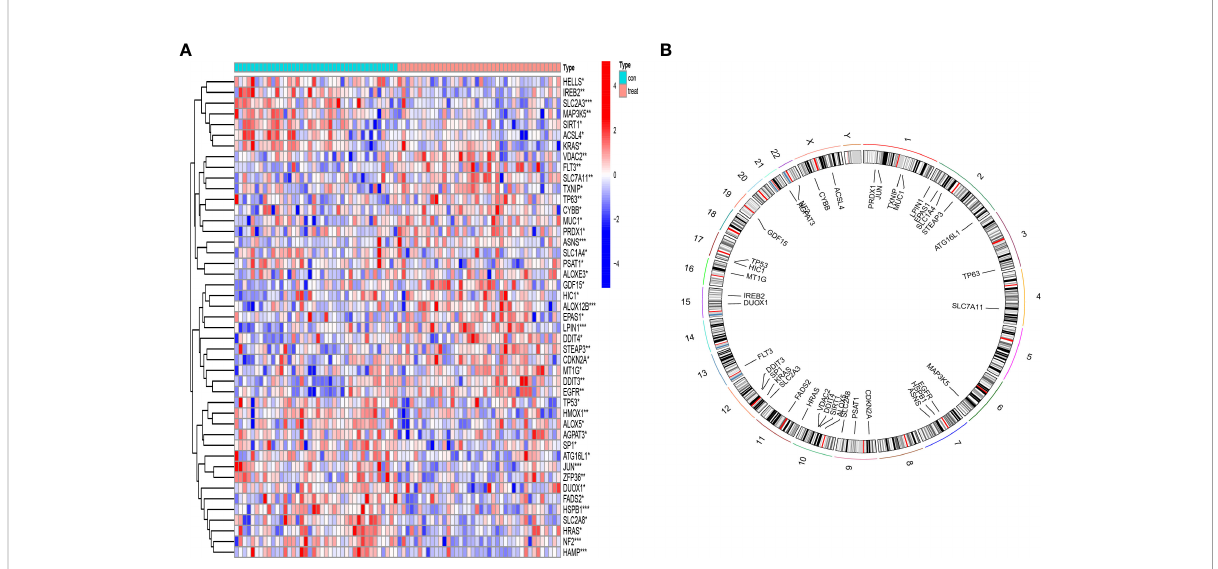
FIGURE 1 Landscape of 45 differentially expressed ferroptosis-associated genes (DEFAGs) in OP patients. (A) Heat map showing the expression of 45 DEFAGs between OP patients and healthy controls. (B) Chromosomal positions of the 45 DEFAGs were shown in the loop graph. *P < 0.05; **P < 0.01; ***P <